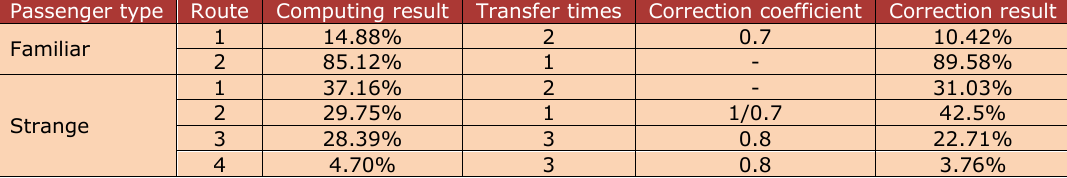
Table 5. Initial Calculation Result and Correction Result